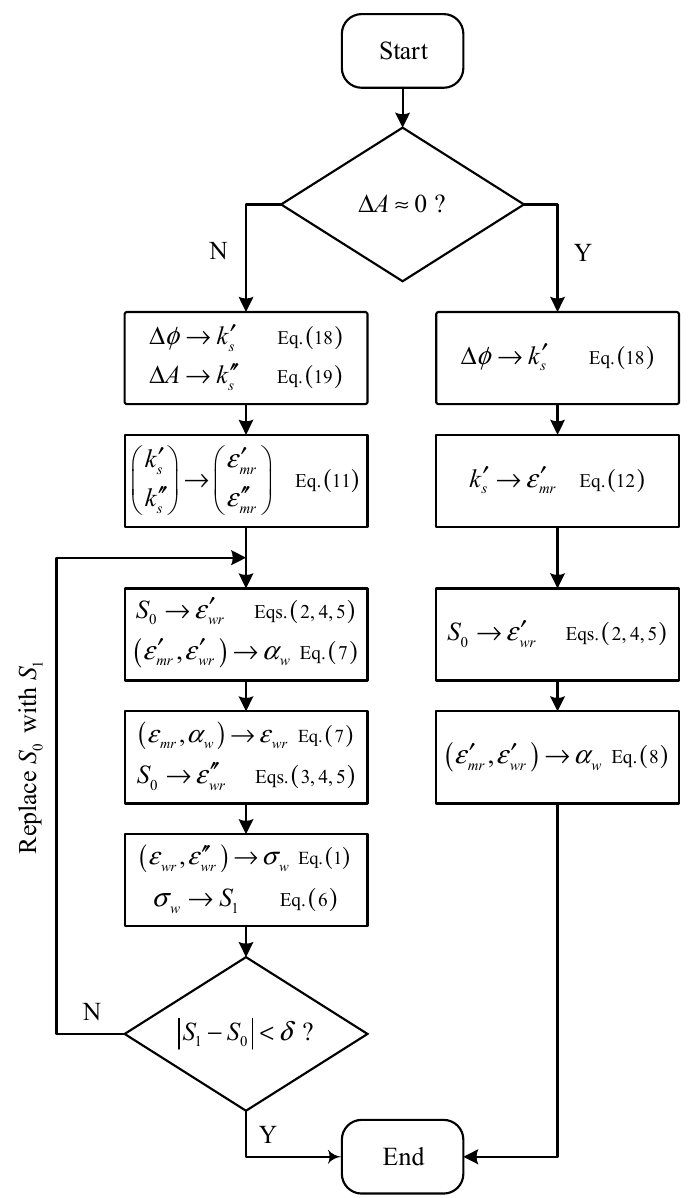
Figure 5. The flow chart of the iteration algorithm for the water cut and salinity calculation.